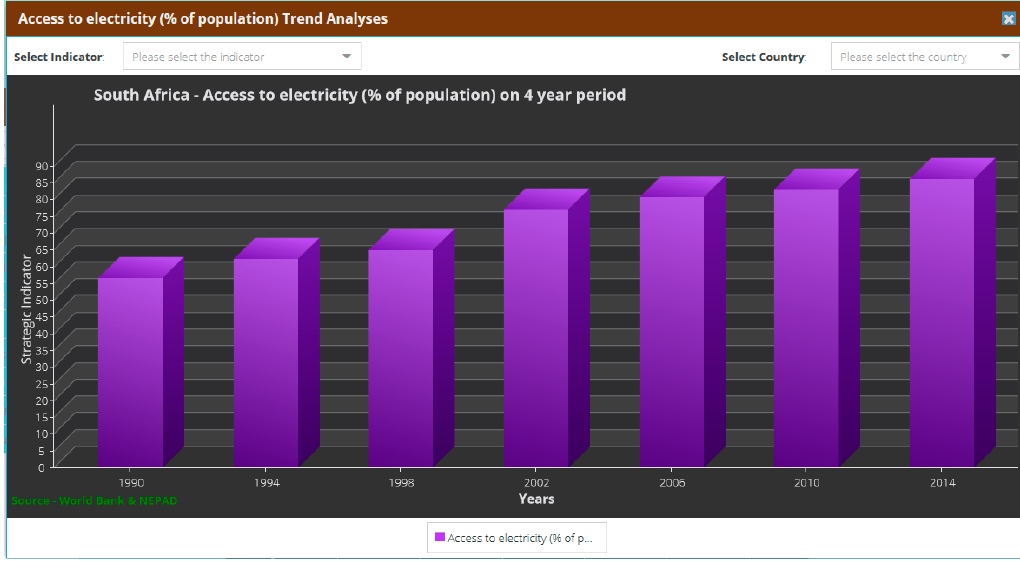
Figure 10. Example of a chart displaying the percentage of the population with access to electricity and how this varies over time.